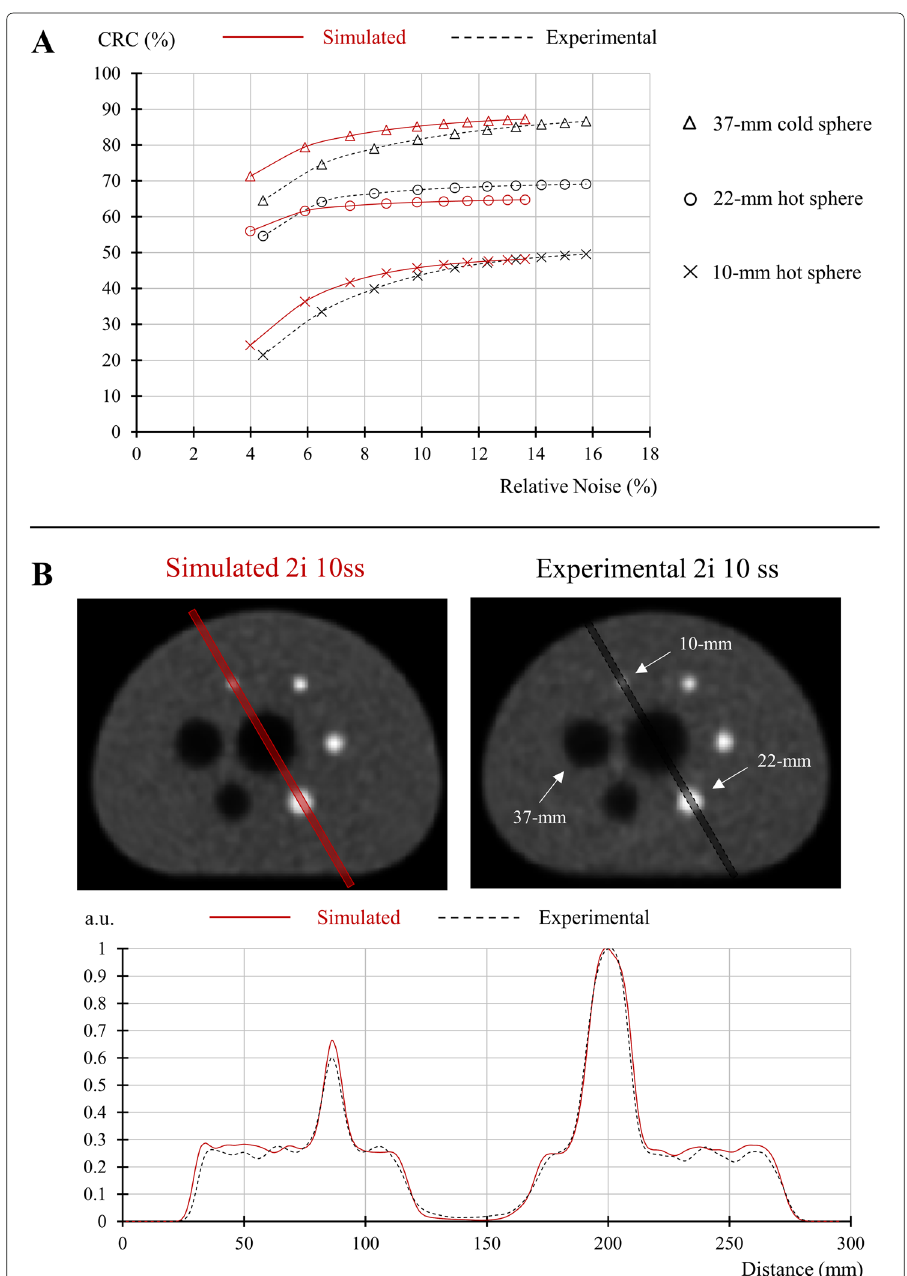
Fig. 7 a Comparison between simulated and experimental images of the relationships between contrast-recovery-coefficients (CRC) and relative noise (RN), according to the number of OSEM iteration and for the 10- and 22-mm diameter hot spheres and the 37-mm cold sphere. b Cross-sectional slices passing through the spheres of the IEC phantom and reconstructed with 2 OSEM iterations and 10 subsets from simulated and experimental data. A parallelepiped profile of 6 mm cross-section and passing through the hot spheres of 10-mm and 22-mm diameter is compared between simulated and experimental